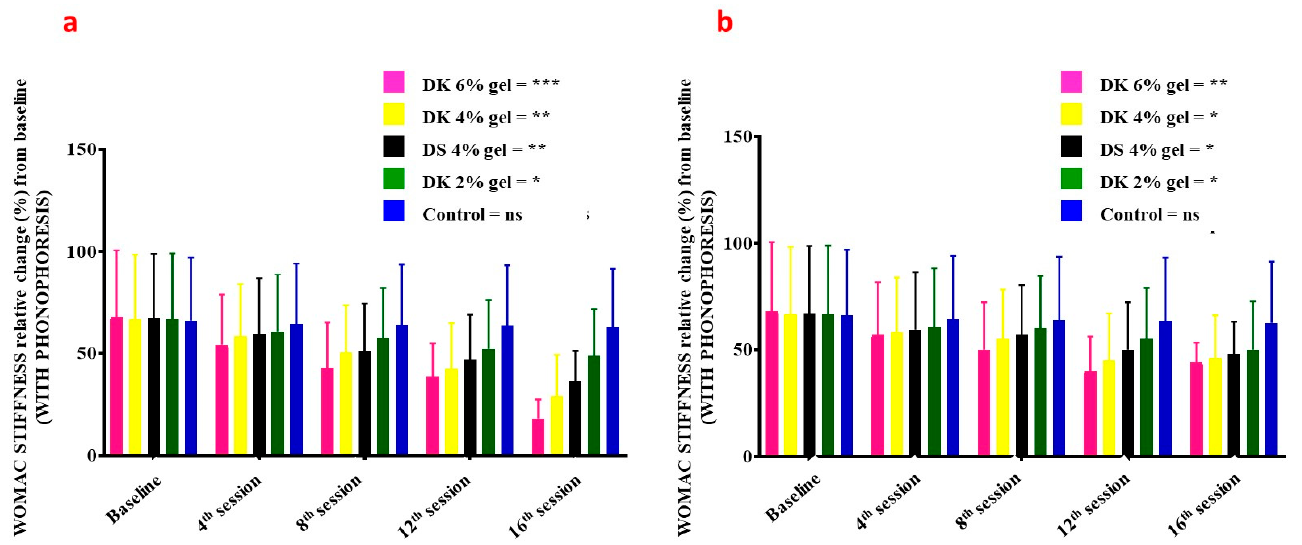
Figure 7. Index of WOMAC stiffness on the baseline, 4th session, 8th session, 12th session, and 16th session of Diclofenac potassium (DK) treatment ( a ) with phonophoresis ( b ) without phonophoresis, in sports-injured patients. Diclofenac sodium (DS) was used as a standard control. Control group is the placebo. Statistical significance ( p -values) is detailed in the main text. ns = no significant; p < 0.05 *, p < 0.01 **, p < 0.001 ***. WOMAC: Western Ontario and McMaster Universities Arthritis Index.